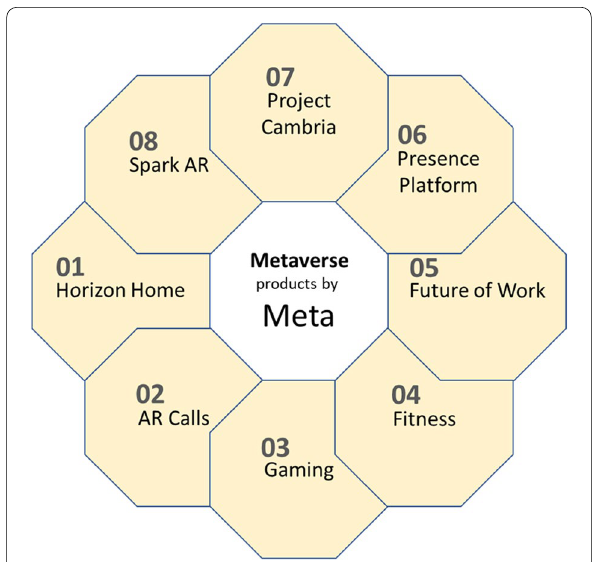
Fig. 1 Products announced by Meta during its product